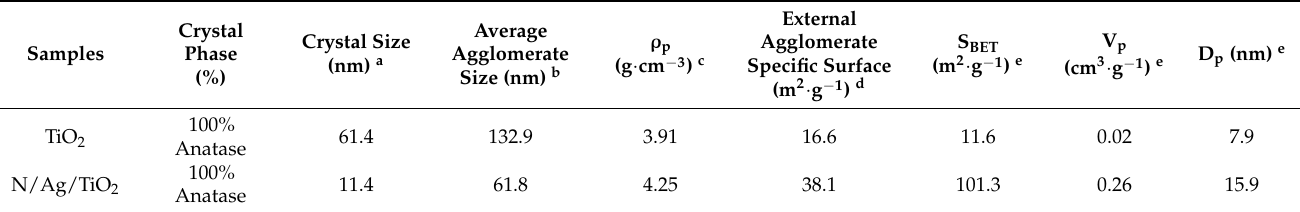
Table 1. Characteristic properties of the synthesized TiO 2 and N/Ag/TiO 2 photocatalysts.